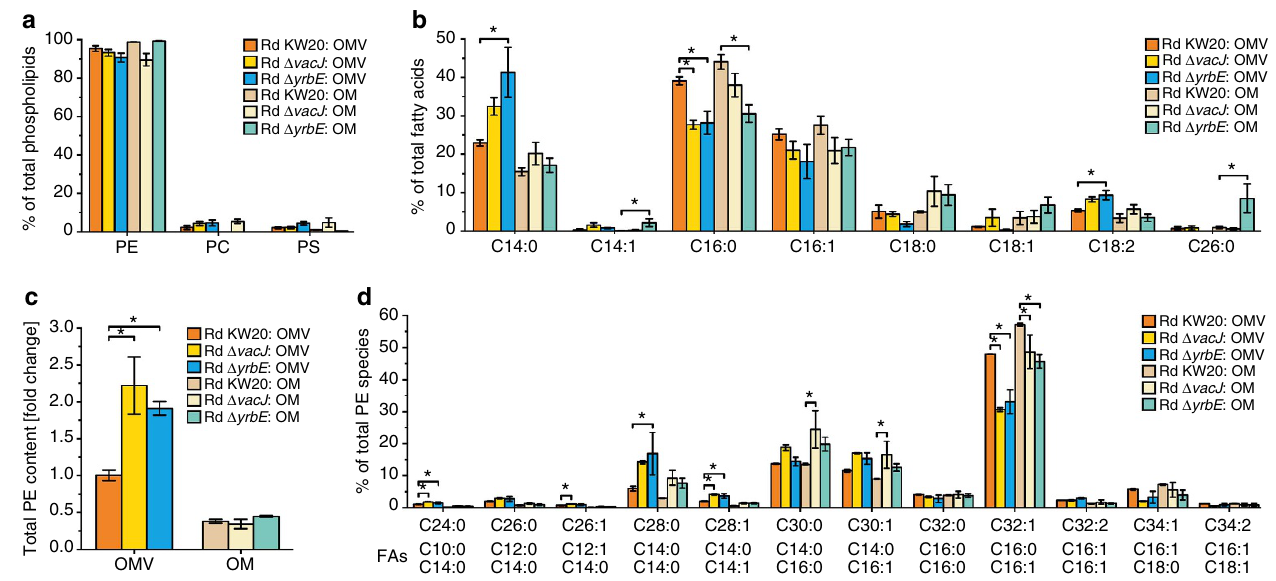
Figure 4 | Lipidome analyses of H. influenzae density gradient purified OMVs and OM. ( a , b ) PL ( a ) and FA ( b ) compositions of OMV and OM preparations derived from Rd KW20, Rd D vacJ , and Rd D yrbE were analysed by thin-layer chromatography and by gas liquid chromatography in combination with flame-ionization detection, respectively. Mean percentage values with s.e.m. of total PLs ( a ) and FAs ( b ) within a given preparation are shown ( n ¼ 3 biological replicates). Detected PLs and FAs were: phosphatidylethanolamine (PE), phosphatidylcholine (PC), phosphatidylserine (PS), myristic acid (C14:0), myristoleic acid (C14:1), palmitic acid (C16:0), palmitoleic acid (C16:1), stearic acid (C18:0), oleic acid (C18:1), linoleic acid